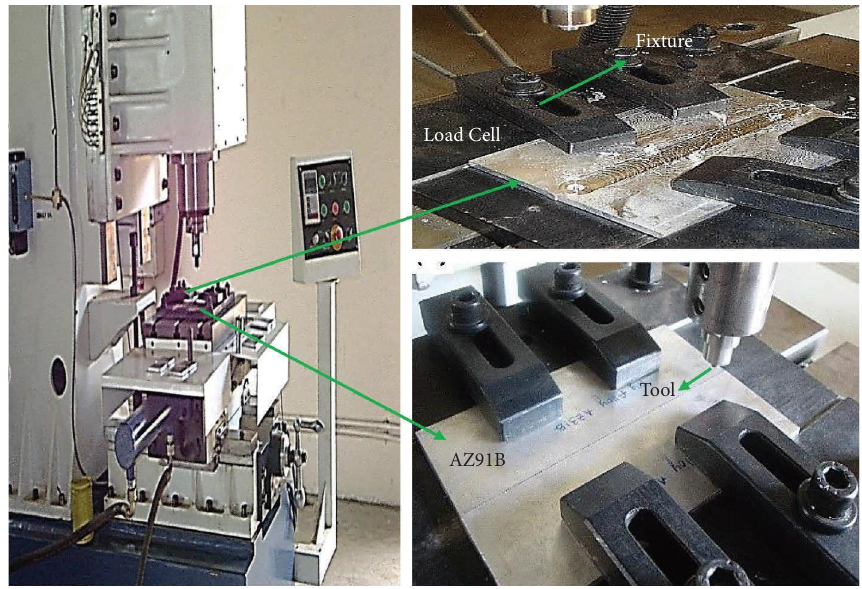
Figure 2: Research work setup.